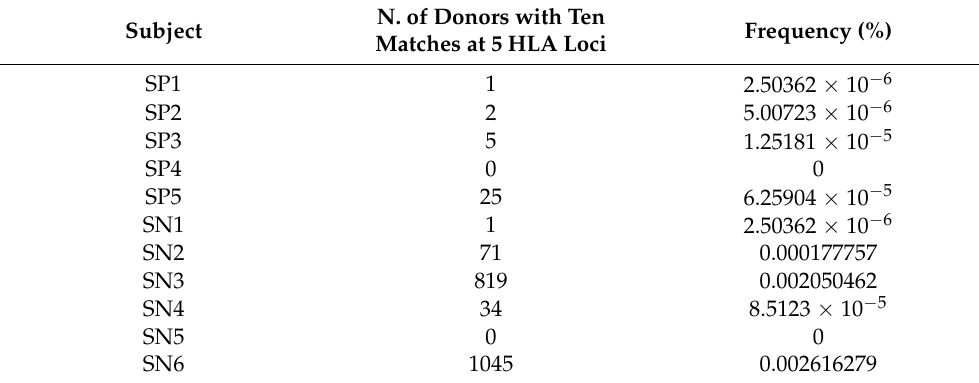
Table 3. Frequency of the patients’ HLA phenotypes in the world population . The table displays the number of individuals with ten matches at five HLA loci for each patient. The definition of these numbers allowed us to calculate the frequency of the patients’ HLA haplotype in the world population. N. of Donors with